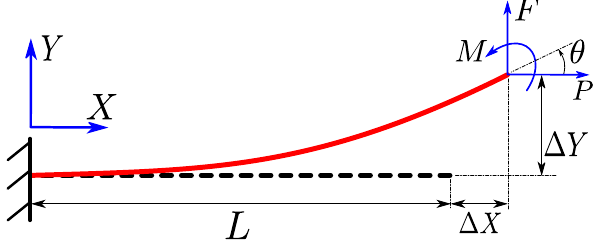
Figure 1. A simple beam flexure subject to combined force and moment